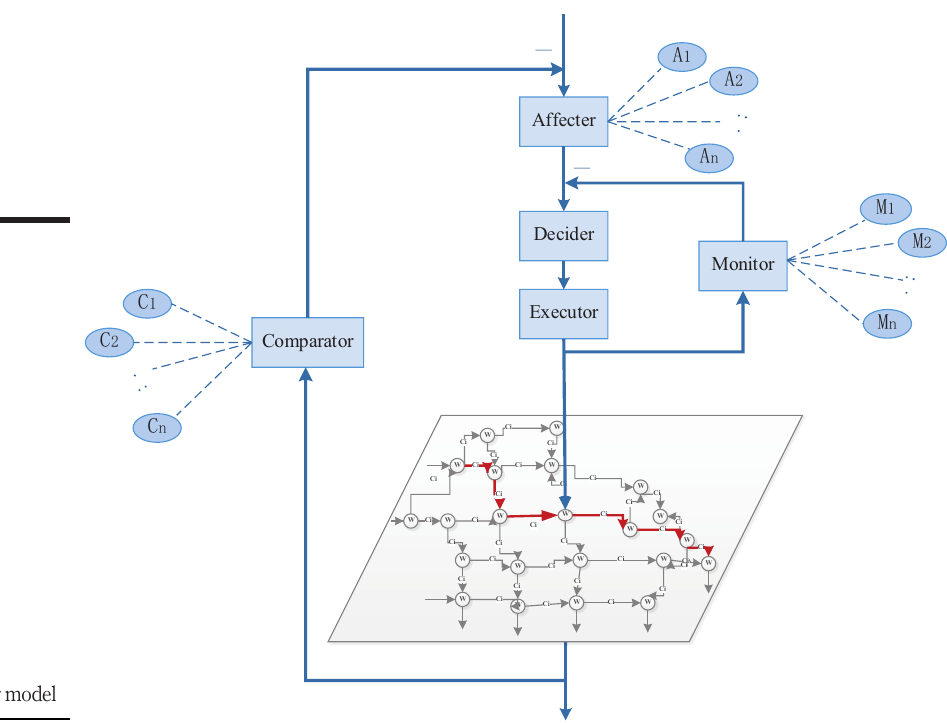
intensity is determined by the interconnection rule. Comparator connects to other units related to the unit and learns from the behavioral results of other units. The result can be used as negative feedback in the next round of selection and its connection strength is also determined by the interconnection rules. The speci fi c functions of each device of each type of member will are described in detail below. 3.1.1 Tra ffi c light model. (1) Pattern As shown in (Figure 2), the pattern in the traf fi c light